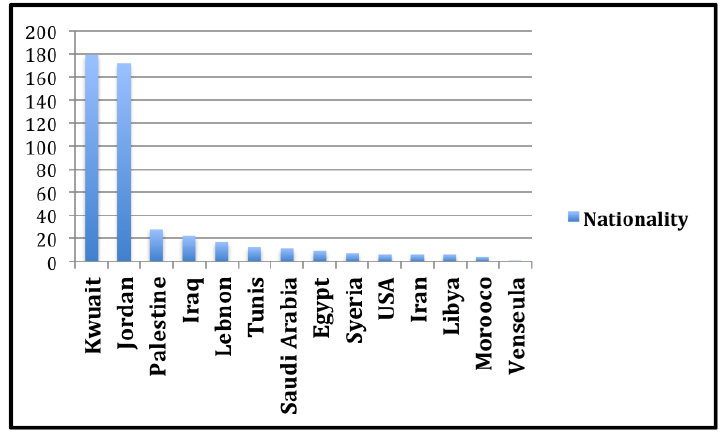
Figure 2. Student nationalities.